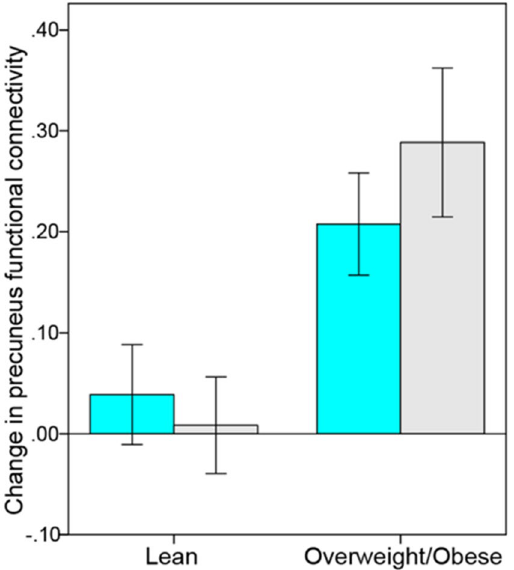
Figure 1. Change in functional connectivity in default-mode network (DMN) based on the posterior cingulate seed region after intranasal insulin (cyan) and placebo (gray) spray. Overweight and obese participants showed a stronger increase in precuneus functional connectivity (rs fMRI2 minus rs fMRI1 ) on both insulin and placebo day compared to lean participants (p FWE < 0.05, whole-brain